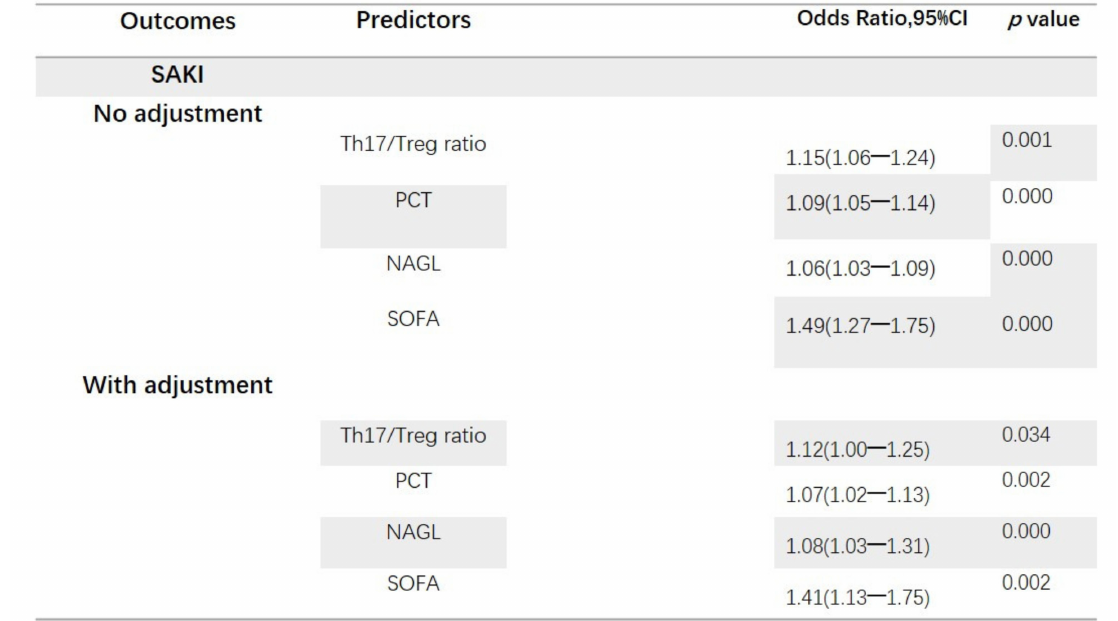
Figure 3. Th17/Treg ratio, PCT, NAGL and SOFA after adjustment association with the occurrence of sepsis-induced acute kidney injury. OR for continuous variables (Th17/Treg ratio, PCT, NAGL, SOFA). OR, odds ratio; CI, confidence interval; SAKI, sepsis-induced acute kidney injury; Treg, regulatory T cell; Th17, helper T cell 17; SOFA, Sequential Organ Failure Assessment; NAGL, neutrophil gelatinase- associated lipocalin; PCT, procalcitonin.